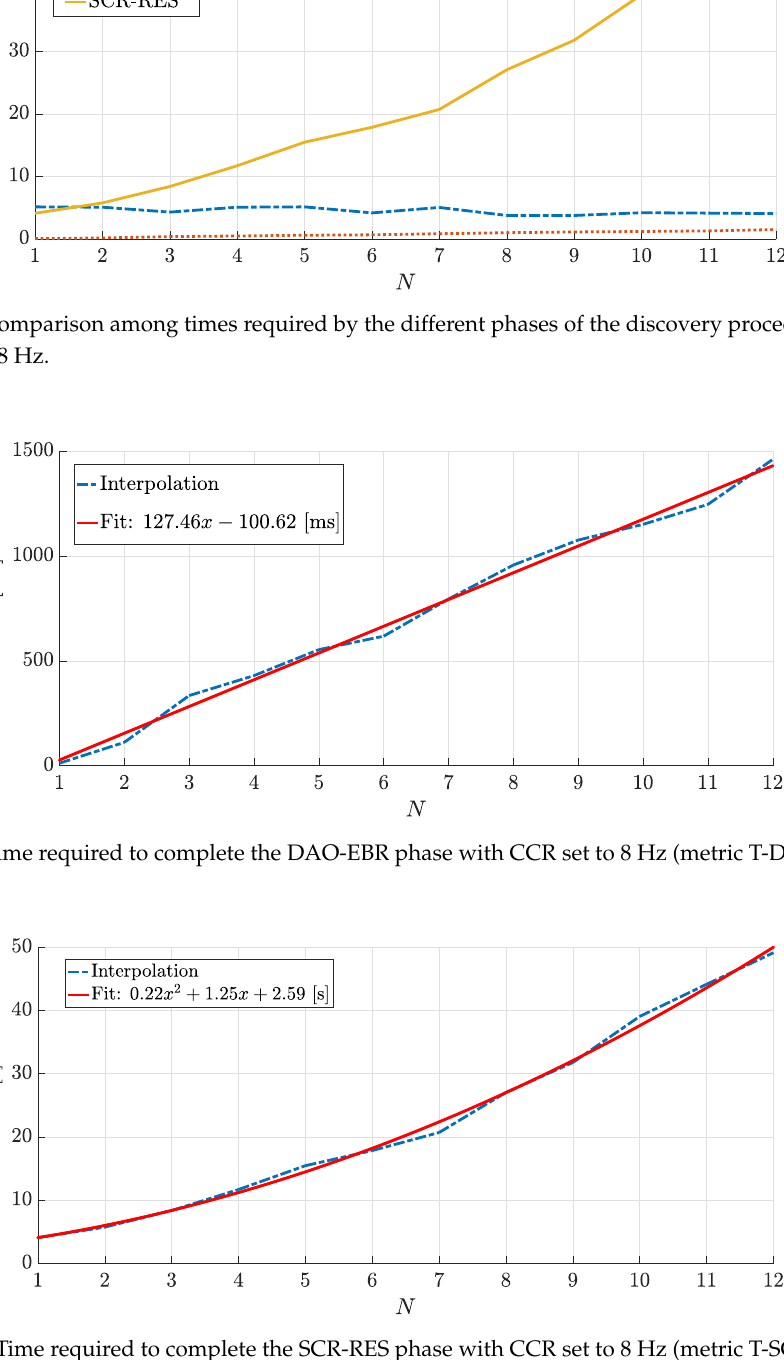
Figure 9. Time required to complete the SCR-RES phase with CCR set to 8 Hz (metric